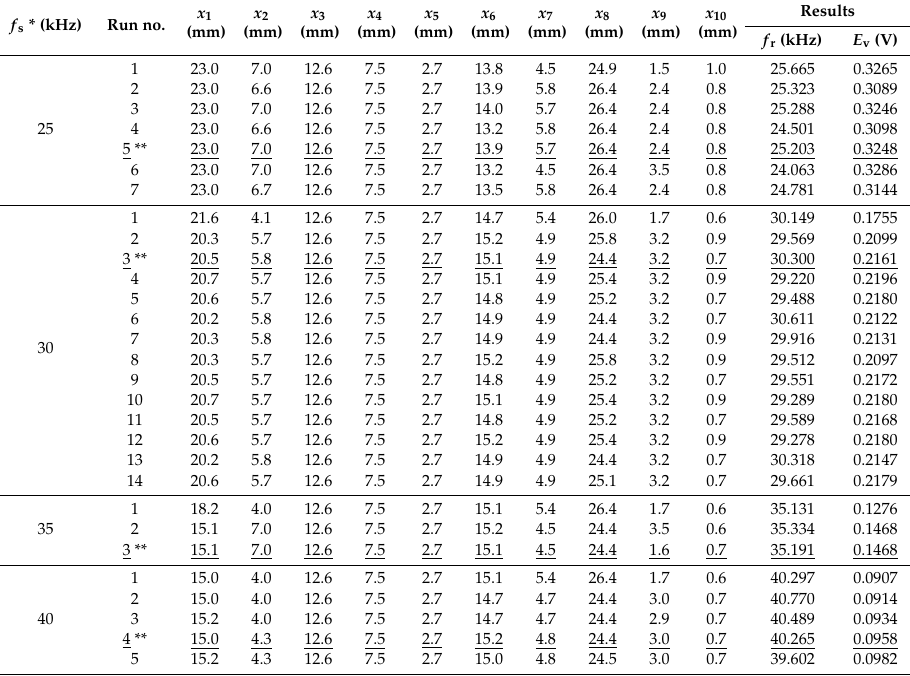
Table 1. Optimization results on design variables at di ff erent set values of resonant frequency f s and corresponding results of resonant frequency f r and electric voltage E v . Design variables are head OD ( x 1 ), head height ( x 2 ), piezoceramic OD ( x 3 ), piezoceramic ID ( x 4 ), piezoceramic thickness ( x 5 ), tail OD ( x 6 ), tail height ( x 7 ), base OD ( x 8 ), base height ( x 9 ), and epoxy thickness ( x 10 ).